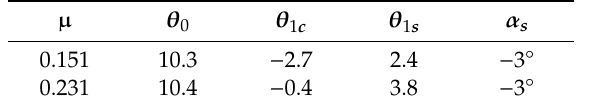
Table 4. Rotor control parameters at di ff erent advance ratios.